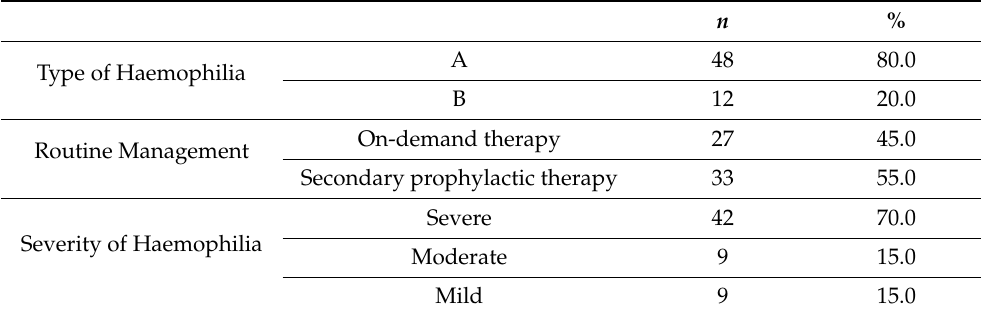
Table 1. Characteristics of the study group including the type and severity of haemophilia and the type of